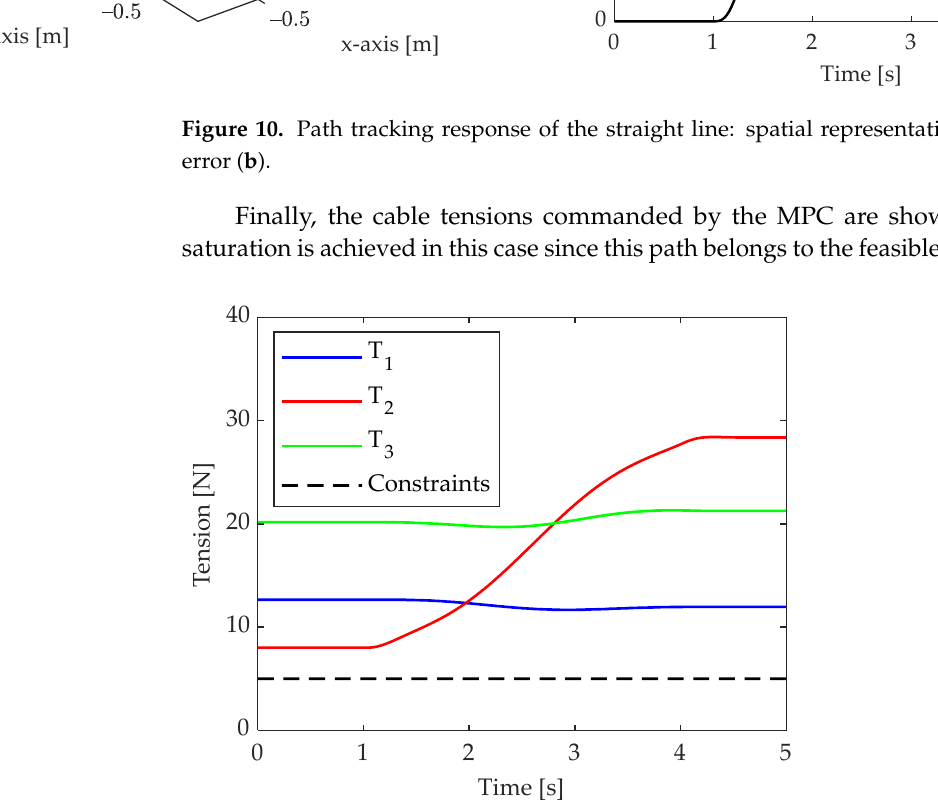
Figure 11. Cable tensions in the execution of the straight line.